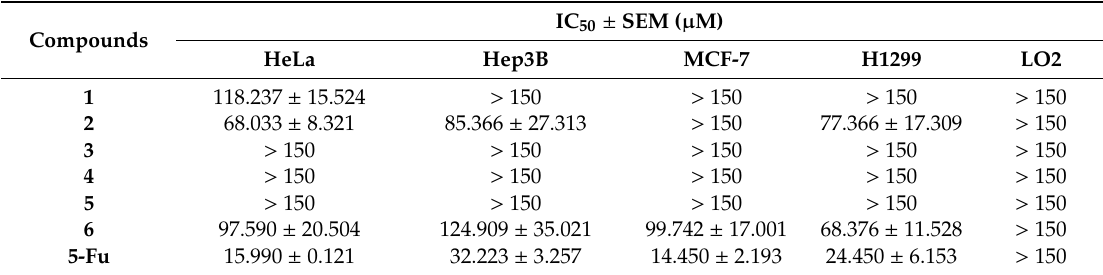
Table 3. Inhibition e ff ects on the growth of tumor cells in vitro (IC 50 , µ